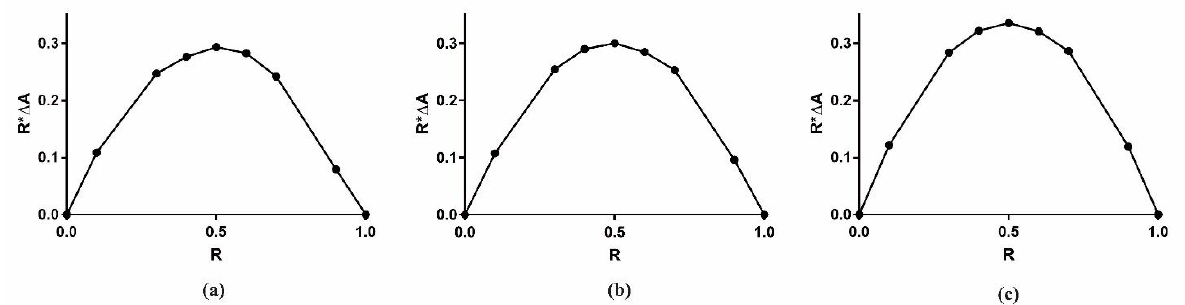
Figure 2. Job plot for the complex: ( a ) Chlorpropham: β - CD (λ = 237.0 nm); ( b ) Monuron: β - CD (λ = ( λ = 245.0 nm); ( c ) Propanil: β -CD ( λ = 250.0 nm). ∆ A is the absorbance difference of the pesticide in 245.0 nm); ( c ) Propanil: β - CD (λ = 250.0 nm). Δ A is the absorbance difference of the pesticide in the absence and in the presence of β -CD. the absence and in the presence of β